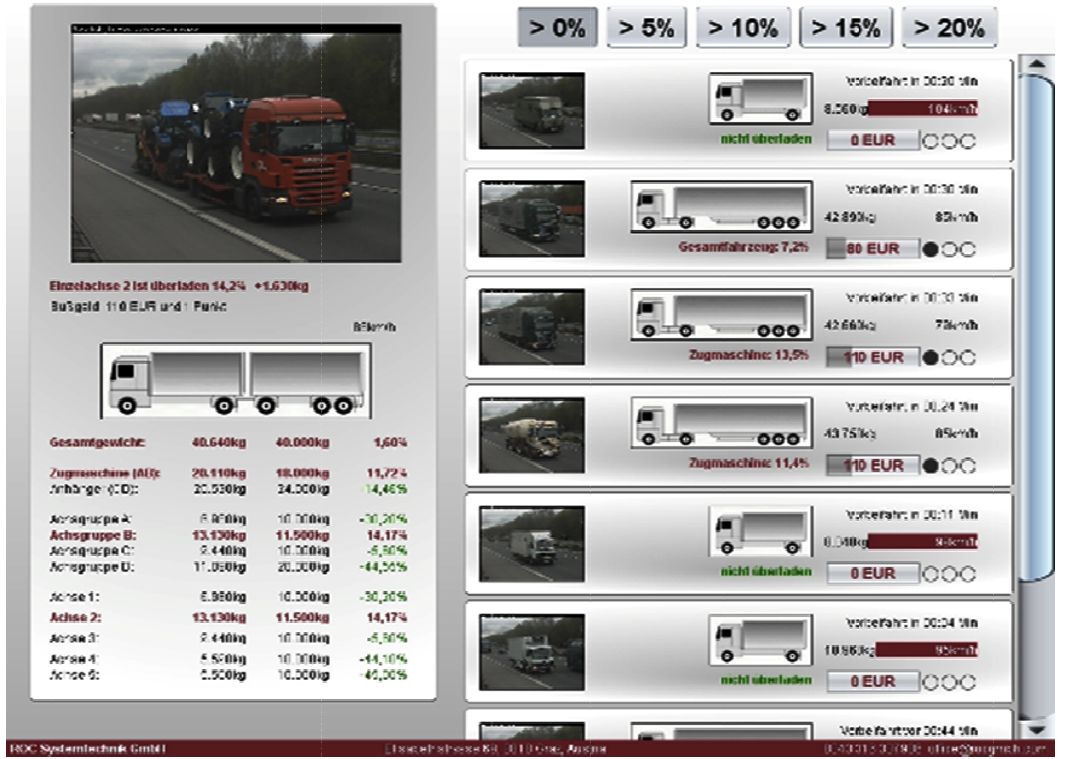
Sensors 201 e 14. Weigh h-in-motion measureme ent applicati